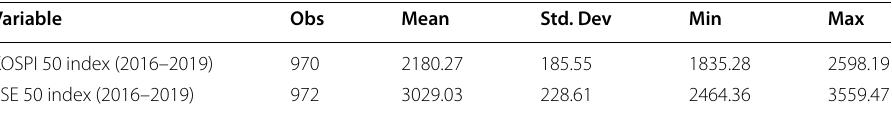
Table 5 Summary